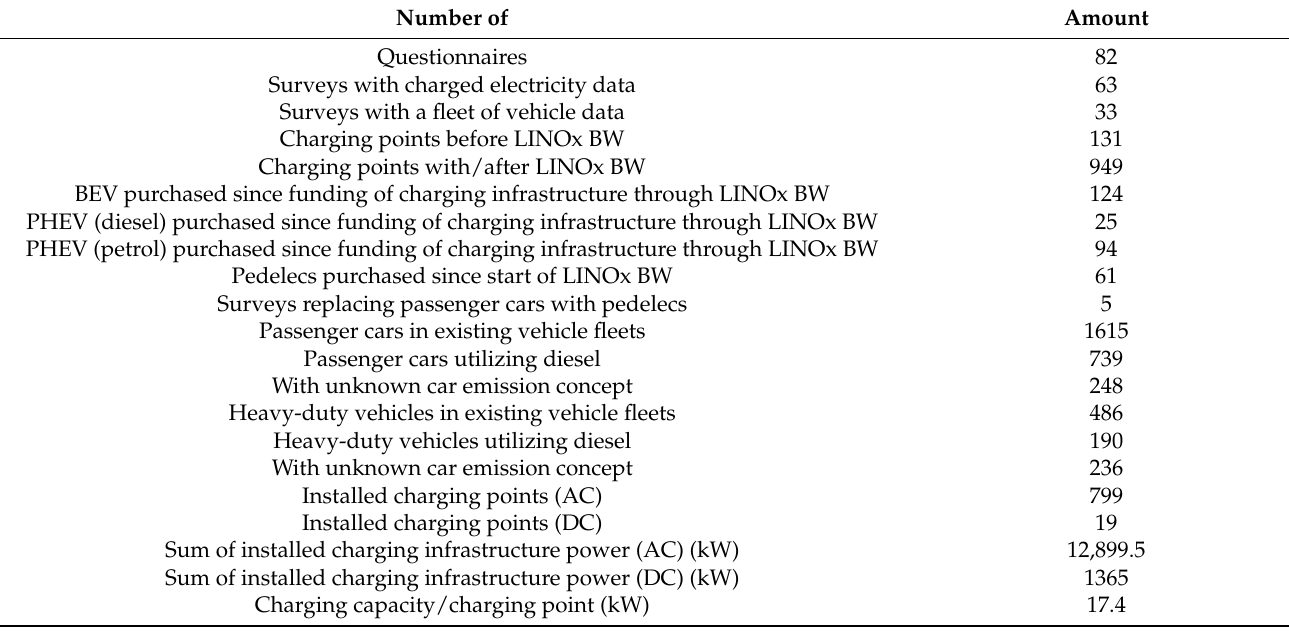
Table 3. Key figures about utilized data for this paper.